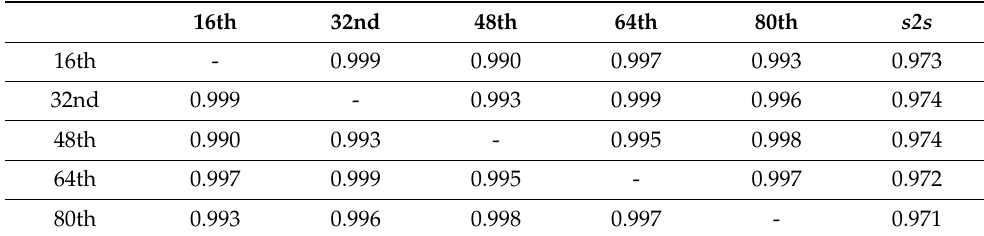
Table 2. Pearson correlation coefficients of Sun-to-SCS distance s2s and 16th, 32nd, 48th, 64th and 80th spectral bands of SCS. 16th 32nd 48th 64th 80th s2s 16th - 0.999 0.990 0.997 0.993 0.973 32nd 0.999 - 0.993 0.999 0.996 0.974 48th 0.990 0.993 - 0.995 0.998 0.974 64th 0.997 0.999 0.995 - 0.997 0.972 80th 0.993 0.996 0.998 0.997 -